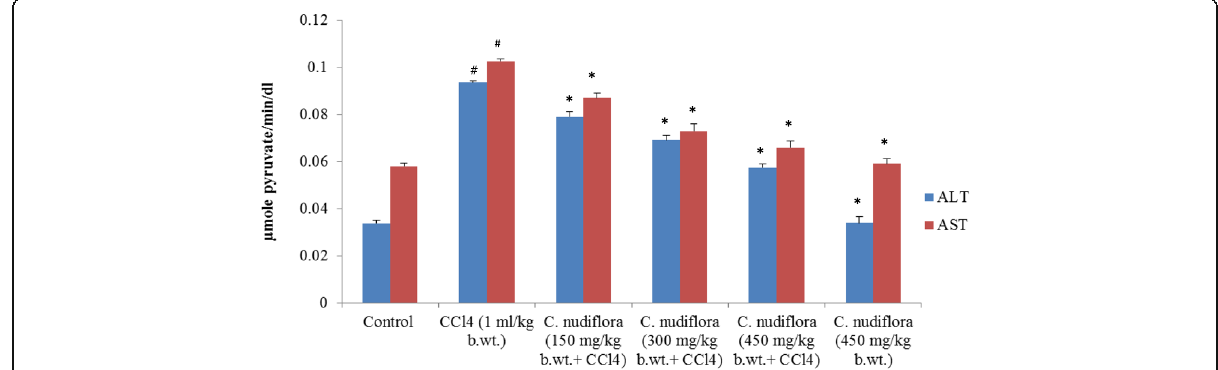
Fig. 3 Effect of C. nudiflora on CCl 4 -induced hepatotoxicity. Each value represents the mean ± S.E. of six animals. Hashtag indicates significance at p < 0.05 compared to the control group. Asterisk indicates significance at p < 0.05 compared to the CCl 4 -treated group